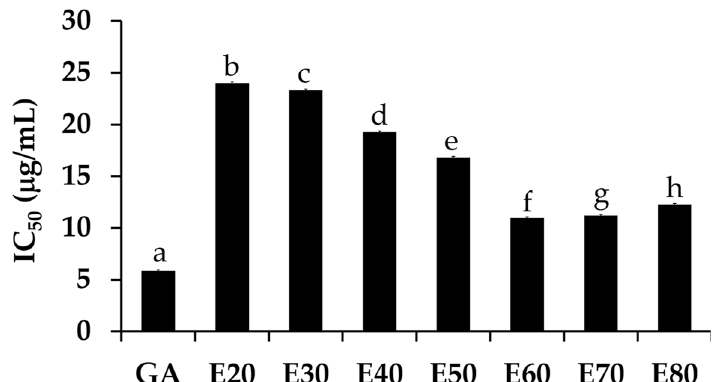
Figure 3. The IC 50 values of the DPPH • scavenging activity of gallic acid (GA) and Sripanya pomegranate peel extracts. E20, E30, E40, E50, E60, E70, and E80 were Sripanya pomegranate peel extracts obtained by maceration in 20%, 30%, 40%, 50%, 60%, 70%, and 80% v/v of ethanol. Different letters denote statistically significant differences among groups; ( p < 0.05).